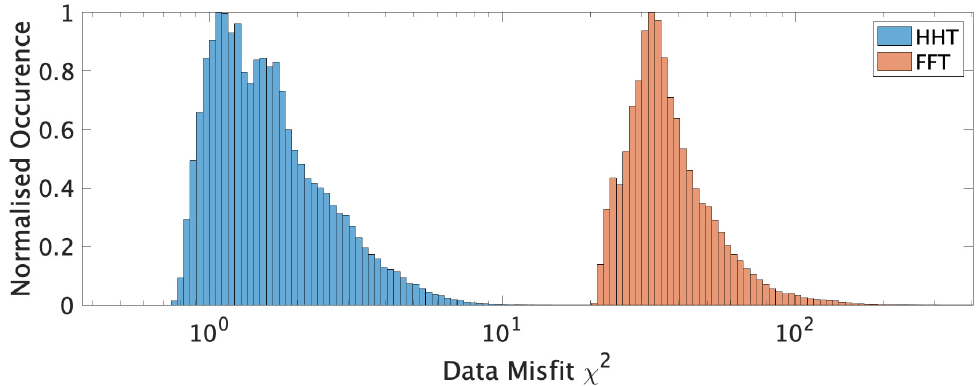
Figure 3. Weighted distribution of tested ICJA inversion models’ χ 2 for FFT and MEMD